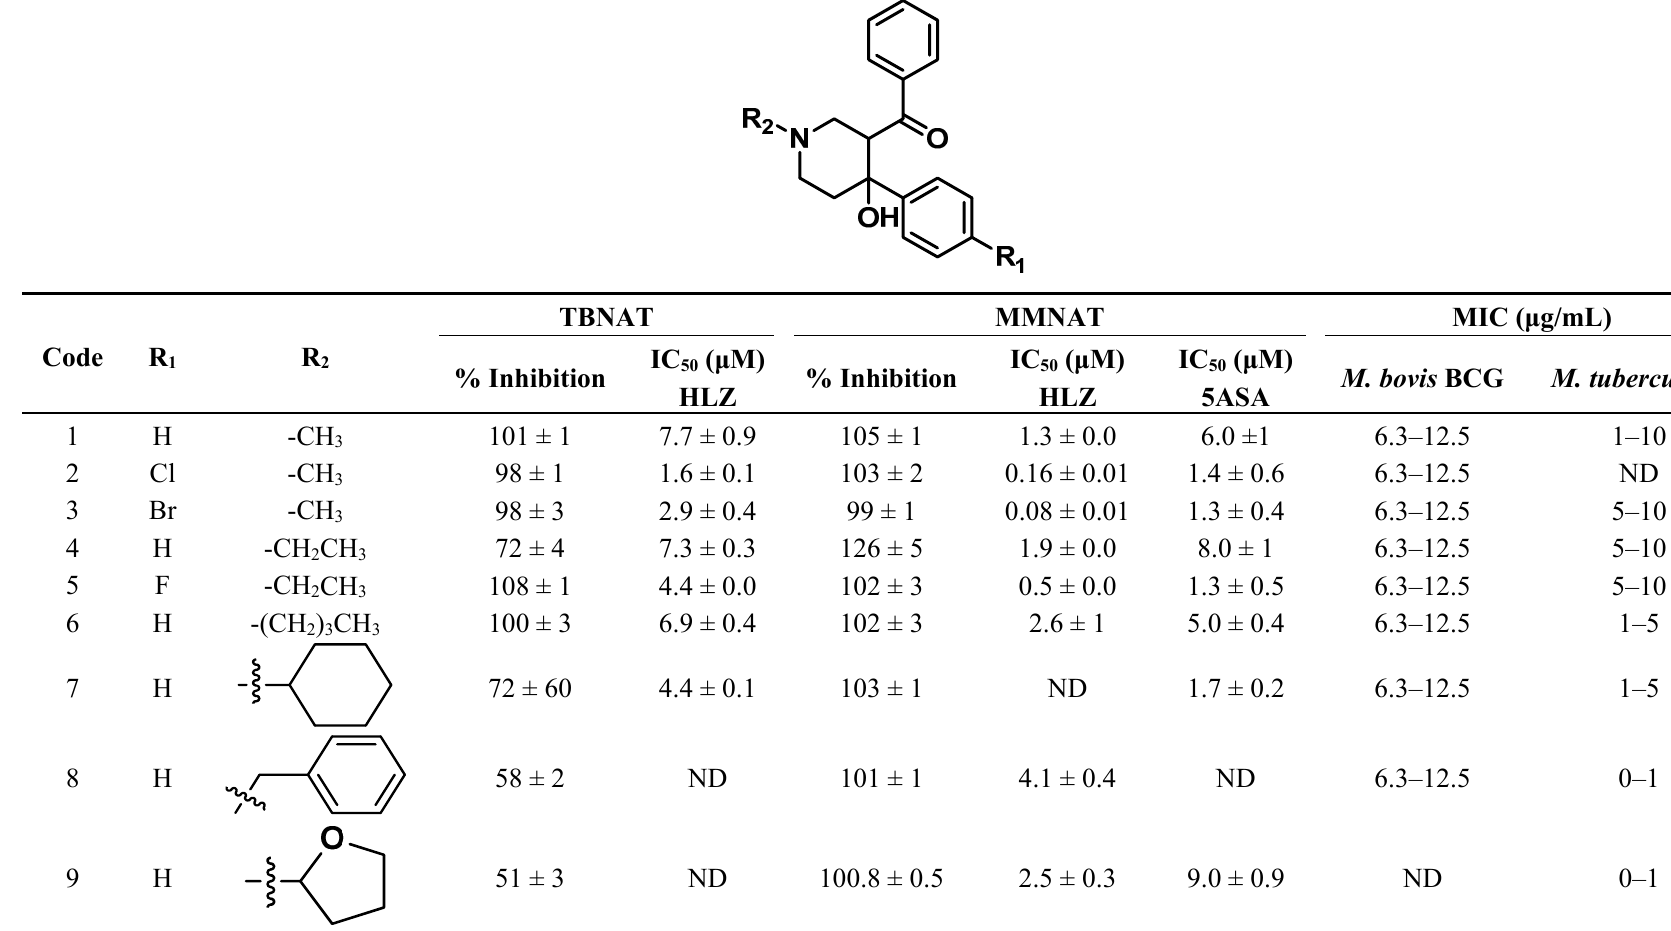
Table 2. The inhibitory activity of compound 1 and its analogues a